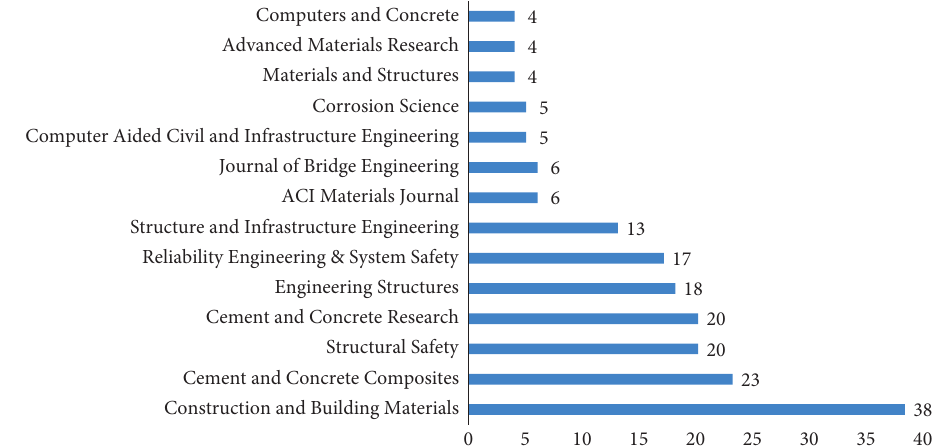
Figure 4: Top 14 journals for research on service life prediction of RC structures in chloride